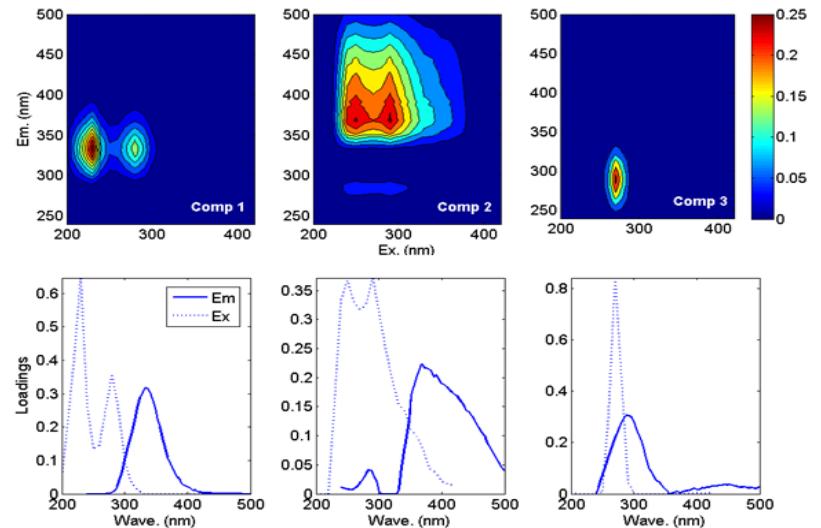
Figure 4. Excitation-emission matrices (EEMs) and excitation and emission spectrum loadings of three fluorescence components from the parallel factor (PARAFAC) model of geothermal water from depths less than 1200 m.